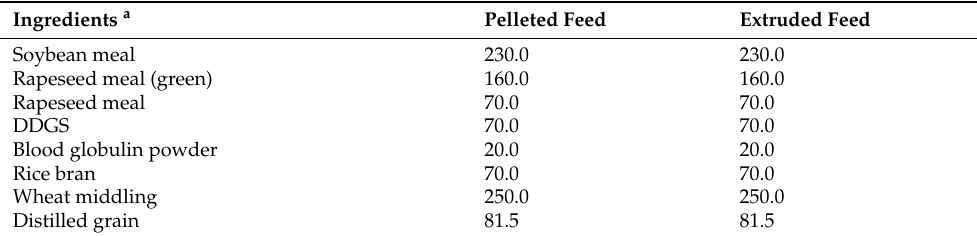
Table 1. Ingredients and proximate composition of experimental feeds (g kg − 1